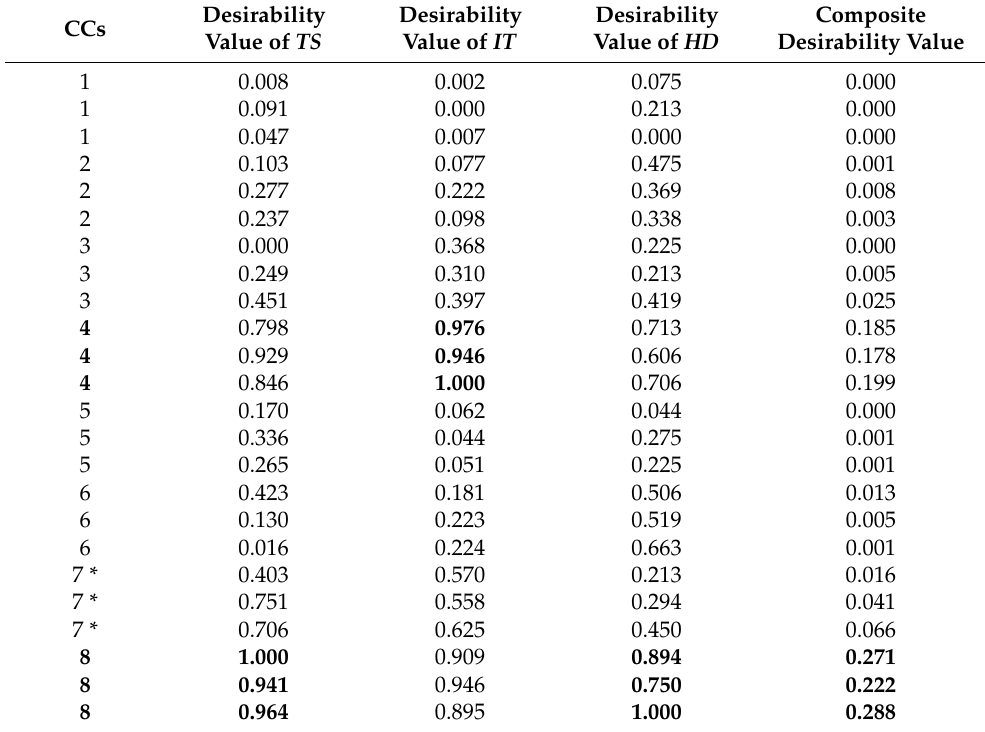
Table 7. Desirability and composite desirability values of the three responses. The highest desirability value of IT was observed at CC4, whereas the highest desirability value of TS, HD and composite desirability values were observed at CC8 (represented by bold letters). Desirability Desirability Desirability CCs Value of TS Value of IT Value of HD